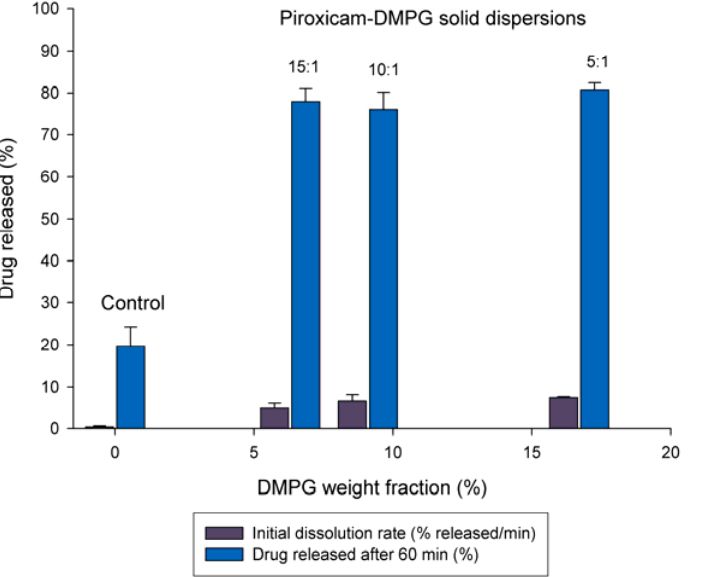
Figure 2. Effect of DMPG weight fraction on the dissolution parameters of piroxicam from solid dispersions at 37 ºC in distilled